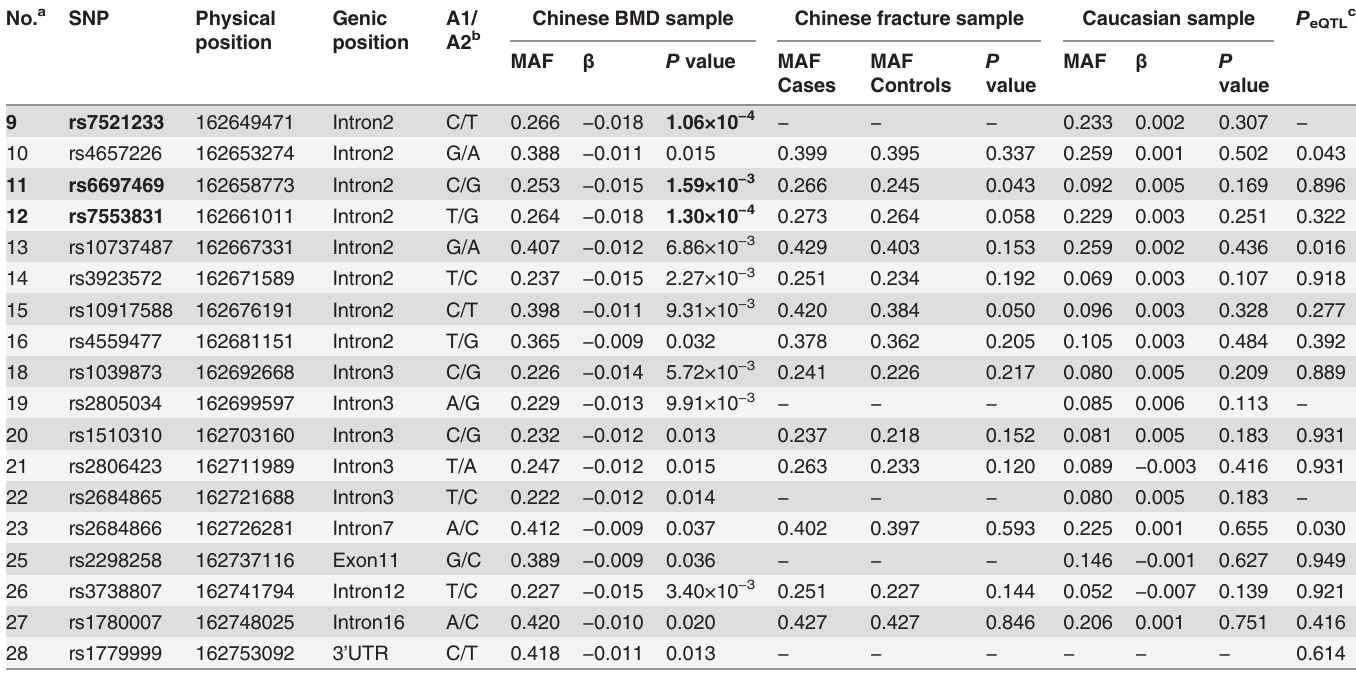
Table 3. Nominally signi fi cant association results for SNPs in DDR2 with BMD and fractures. No. a